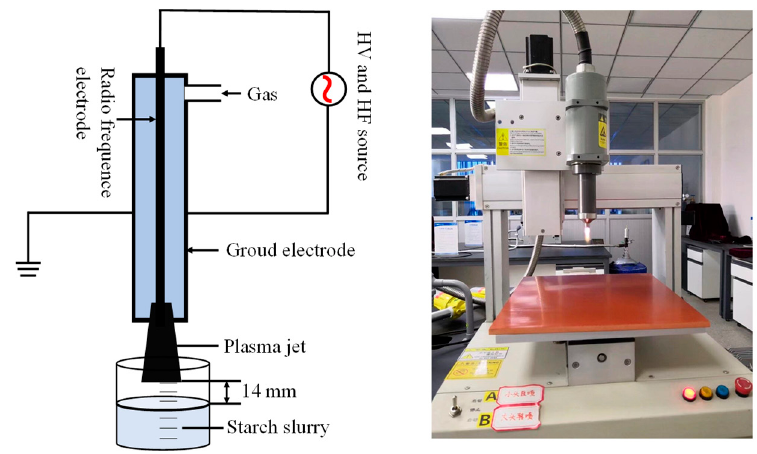
Figure 1. The schematic and device diagram of the atmospheric pressure plasma jet (APPJ) apparatus.